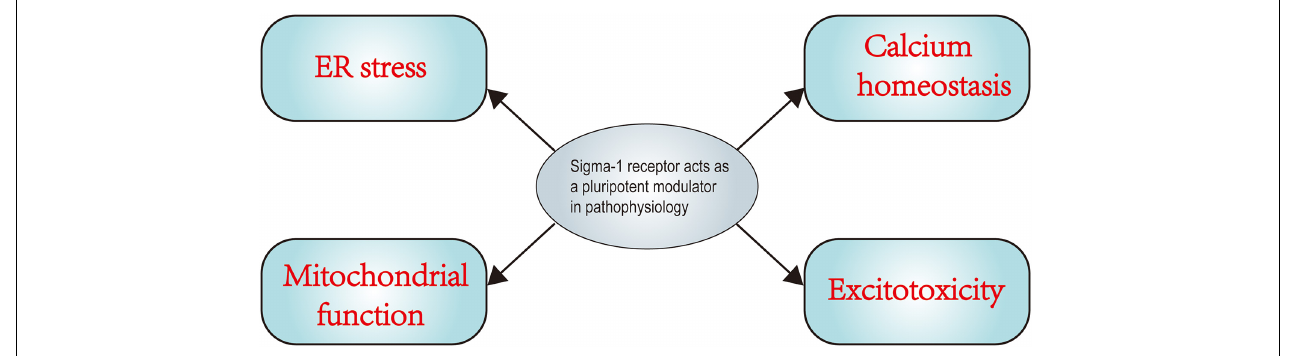
FIGURE 4 | Sigma-1 receptor acts as a pluripotent modulator in pathophysiology. The figure indicates a summary of the mechanism in main pathophysiological processes in which sigma-1 receptor (Sig-1R) plays a key role. Numerous pharmacological studies have confirmed the positive effects of Sig-1R activation on cellular calcium homeostasis, excitotoxicity, ER stress, mitochondrial function. More experiments and further investigations are urgently needed to advance our understanding of Sig-1R and its specific role in traumatic brain